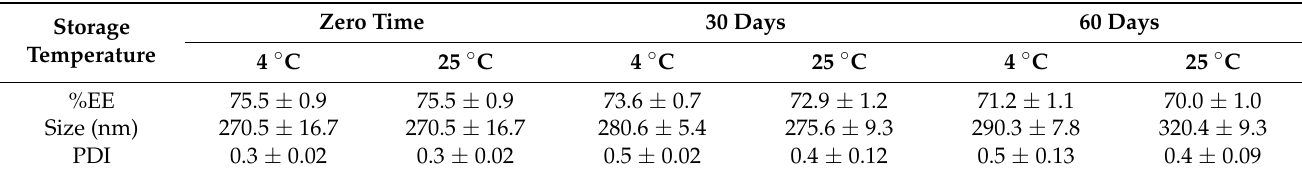
Table 4. Effect of storage at room temperature (25 ◦ C) and 4 ◦ C on the percent drug